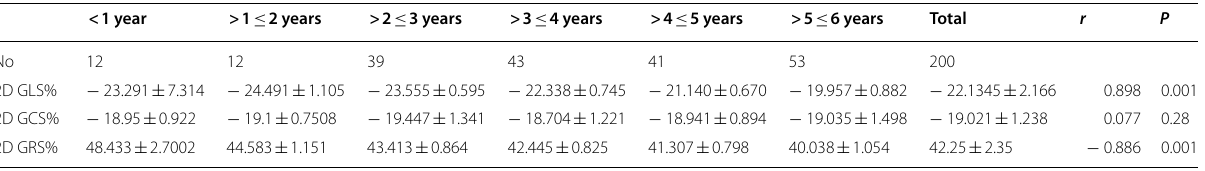
2D two-dimensional, GLS global longitudinal strain, GCS global circumferential strain, GRS global radial